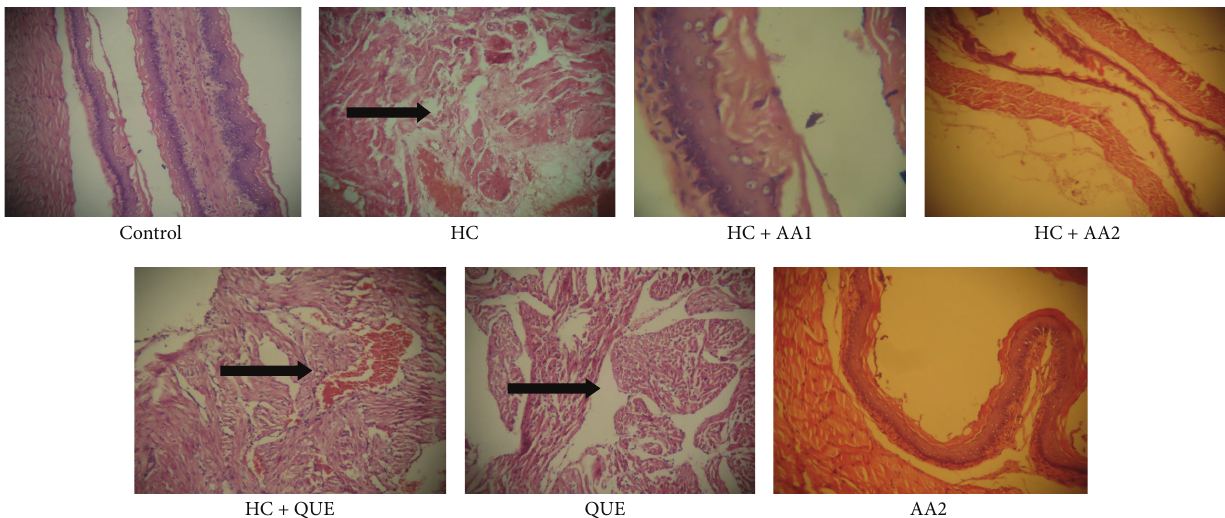
Figure 7: Changes in histology of aorta from hypercholesterolemic rats treated with Artocarpus altilis and Questran for nine consecutive weeks (M × 400). HC: cholesterol at 30 mg/0.3 mL, AA1: Artocarpus altilis at 100mg/kg, AA2: Artocarpus altilis at 200 mg/kg, and QUE: Questran at 0.26 g/kg. Black arrows shows myofibril necrosis, severe hemorrhages, and fibrous connective tissue laid